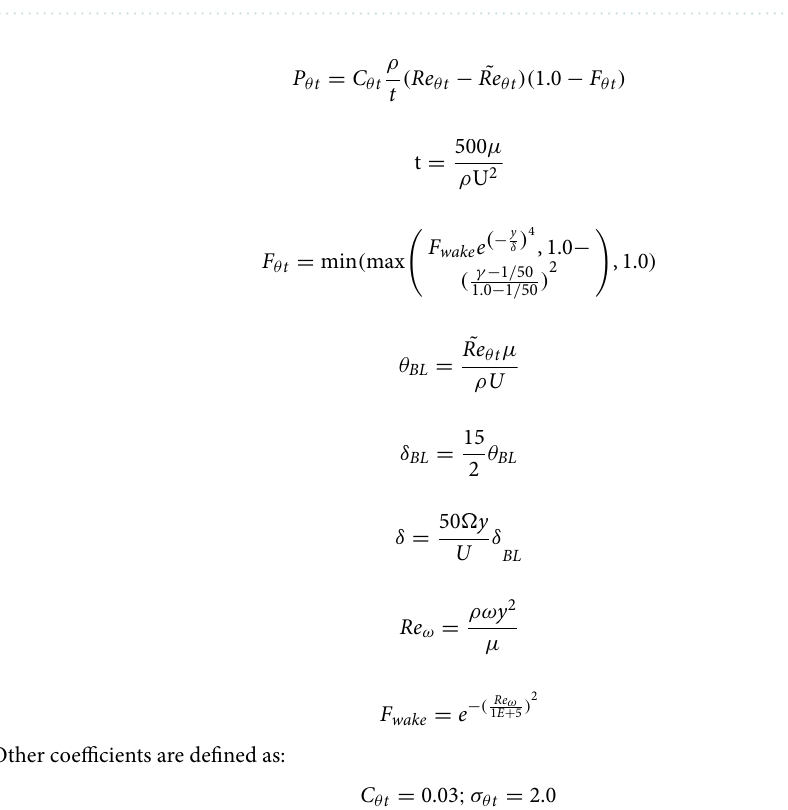
Figure 2. Computational grid of